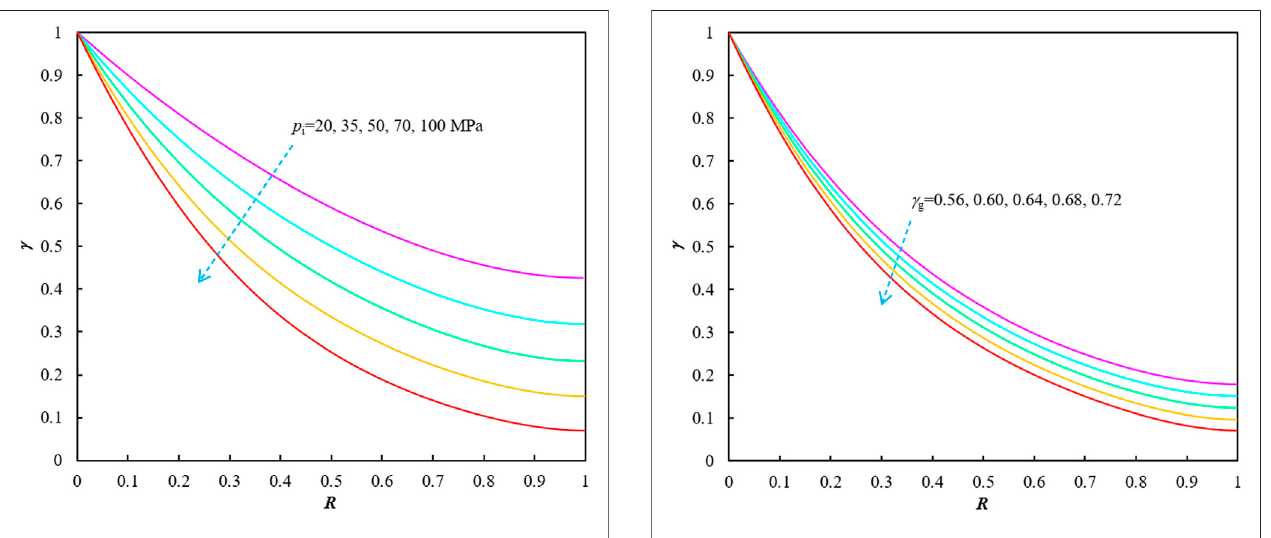
FIGURE 1 | The effects of initial reservoir pressure on c vs. R relationships ( T (cid:1) 90 ° C and c g (cid:1) 0.6).10 Data Availability Statement [not available in Crossref]